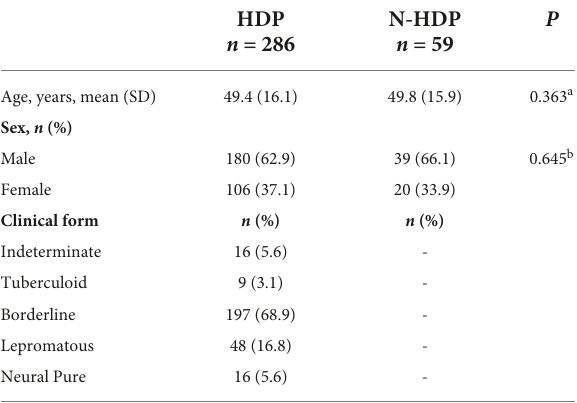
TABLE 1 Study population characteristics ( N =